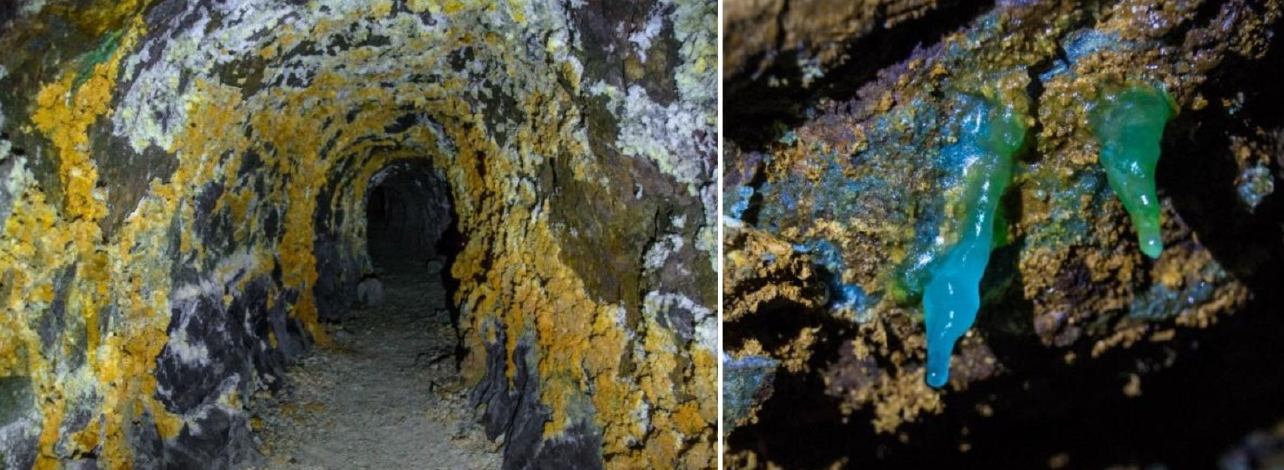
Figure 5. Gypsum from the Jozef adit (photo by Silvia Palgutová). Figure 5. Co-pickeringite from the Jozef adit (photo by Silvia Palgutov á ).